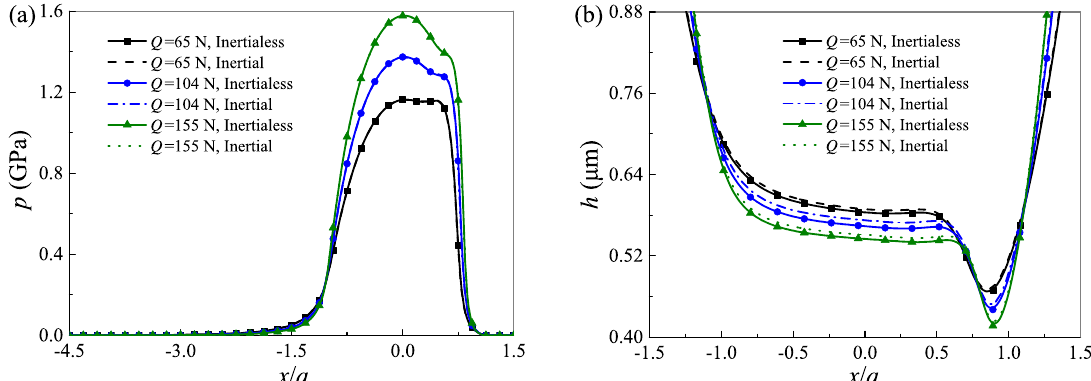
Fig. 5. Effects of inertia on TEHL properties at varied applied load ( y =0): (a) fi lm pressure, and (b) fi lm thickness.